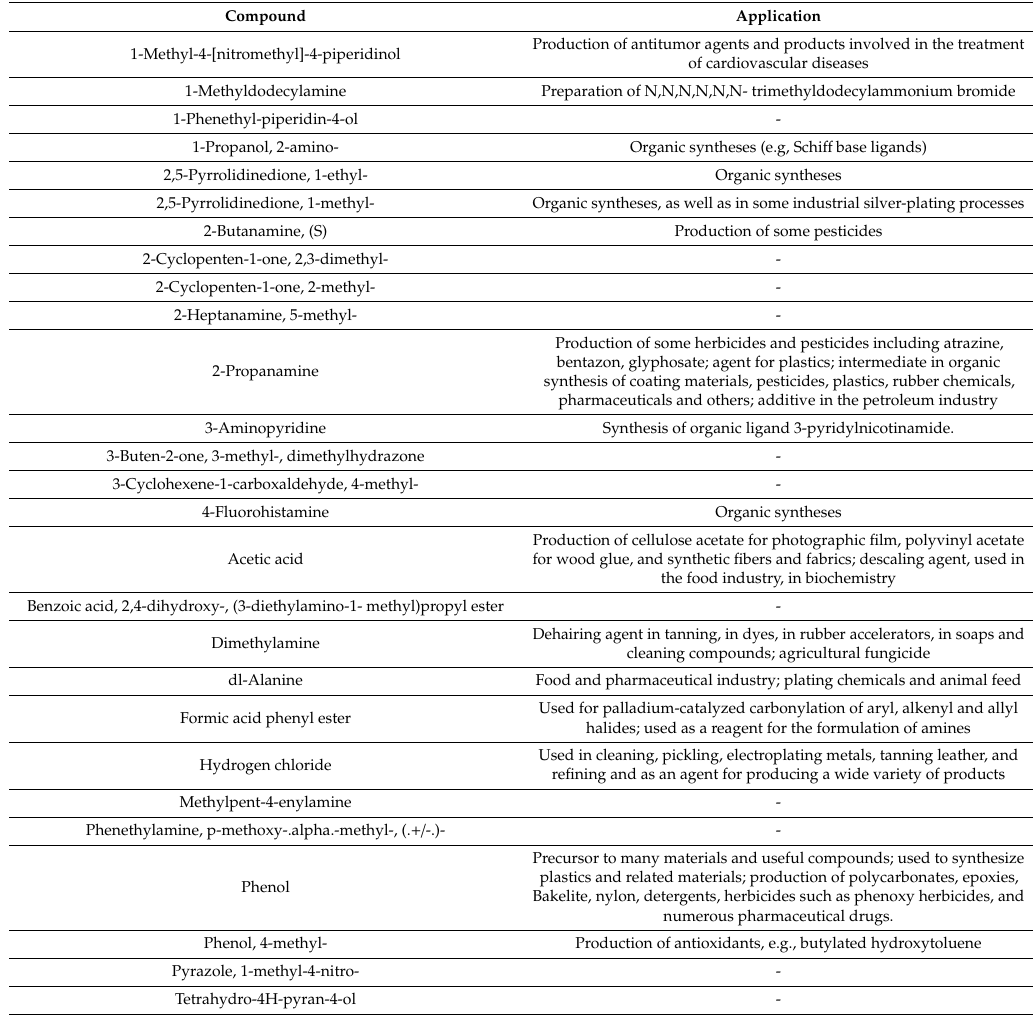
Table 4. Compounds identified in the HTC process water from HTC of anaerobically digested sewage sludge (ADSS) and their main possible application. Adapted from Berge et al.